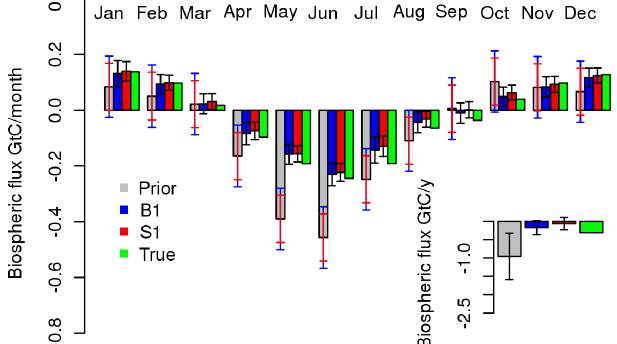
Figure 7. Monthly and annual carbon flux budget, integrated over the European domain. Note that both inversions share the same an- nual prior uncertainty but monthly uncertainties differ. Blue and red error bars denote the prior uncertainty for the B1 and S1 scenarios,